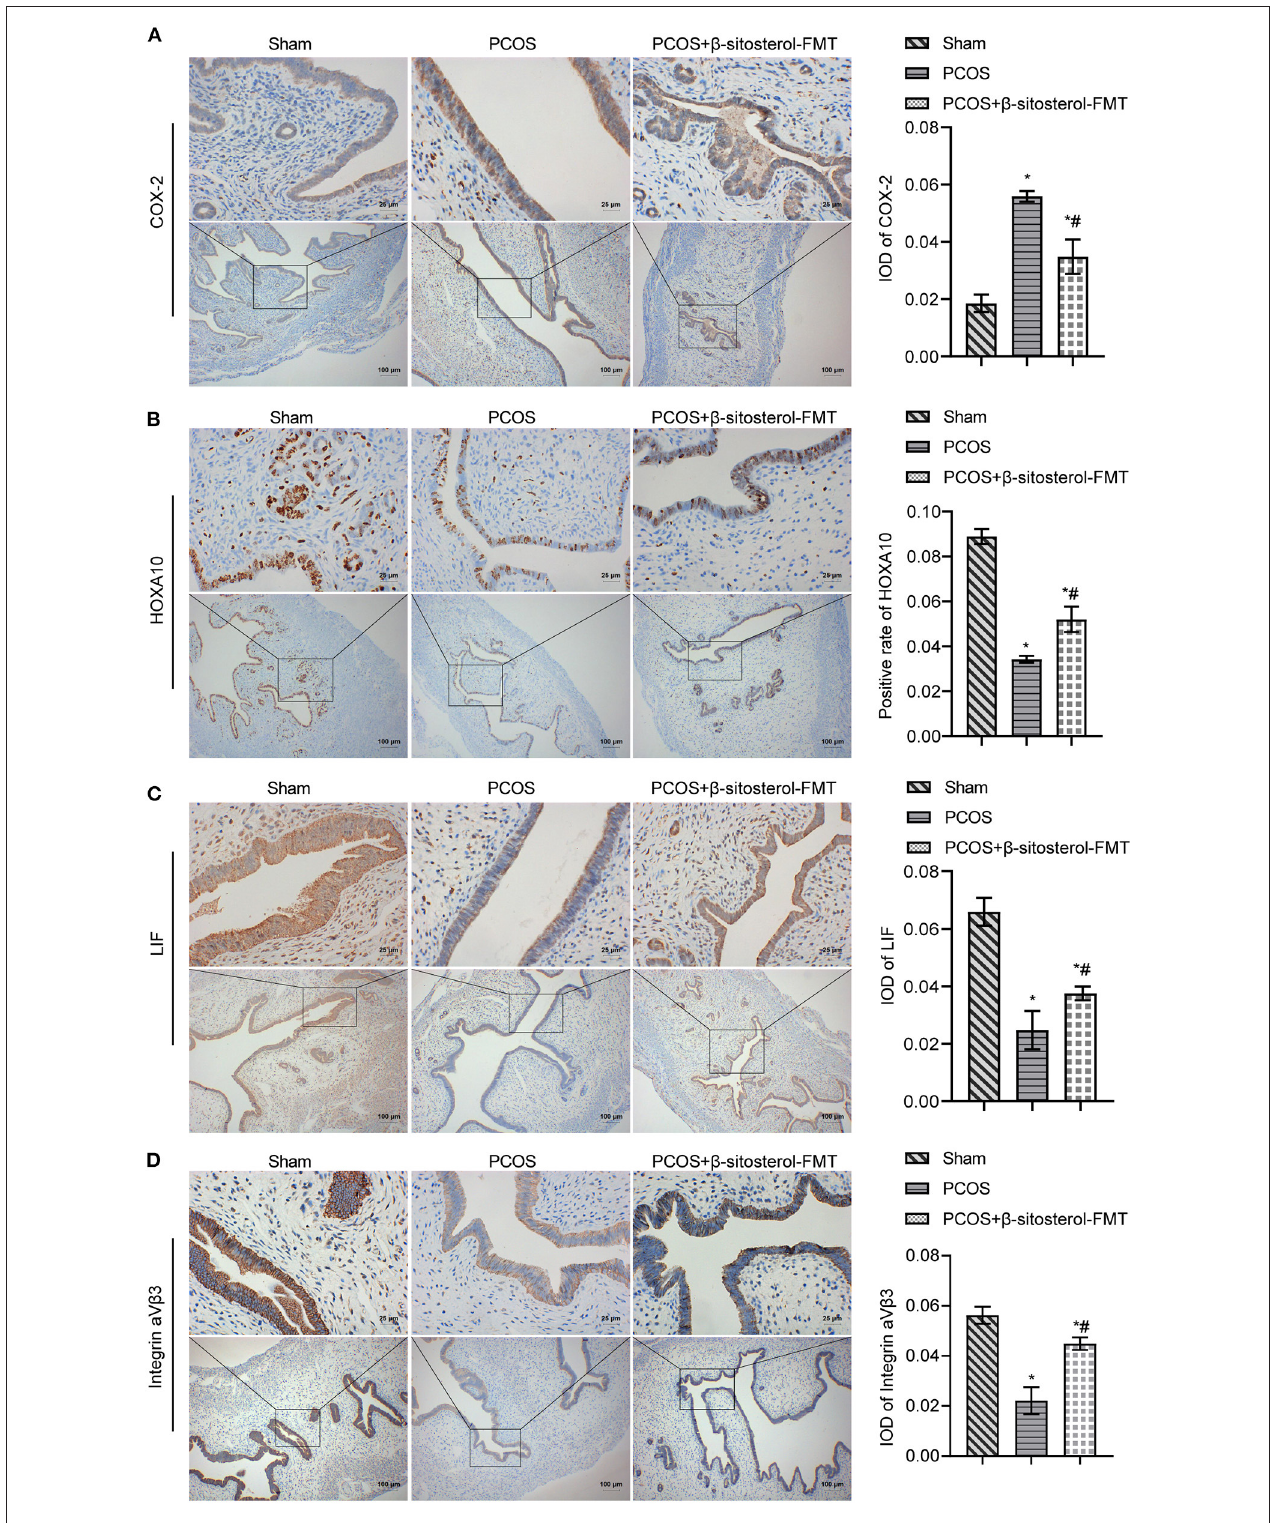
FIGURE 7 | Effect of β -sitosterol-FMT on the expressions of endometrium receptivity markers and related hormones in mice with PCOS. (A–D) Expressions of COX-2, HOXA10, LIF, and Integrin ανβ 3 in the endometrium of mice in each group were detected by IHC. Upper images are magnified 400-fold (scale bar = 25 µ m), and underneath images are magnified 100-fold (scale bar = 100 µ m). Data are presented as mean ± SEM. * P < 0.05 vs. Sham. # P < 0.05 vs. PCOS. PCOS, polycystic ovary syndrome; COX-2, cyclooxygenase-2; HOXA10, homeobox A10; LIF, leukemia inhibitory factor; ELISA, enzyme-linked immunosorbent assay.